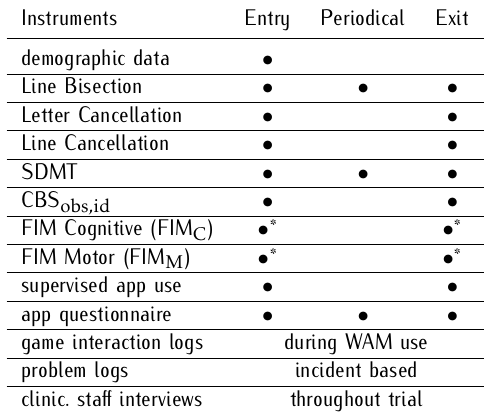
Table 1. Instruments for data collection. Measures marked with * were obtained at admission and discharge from